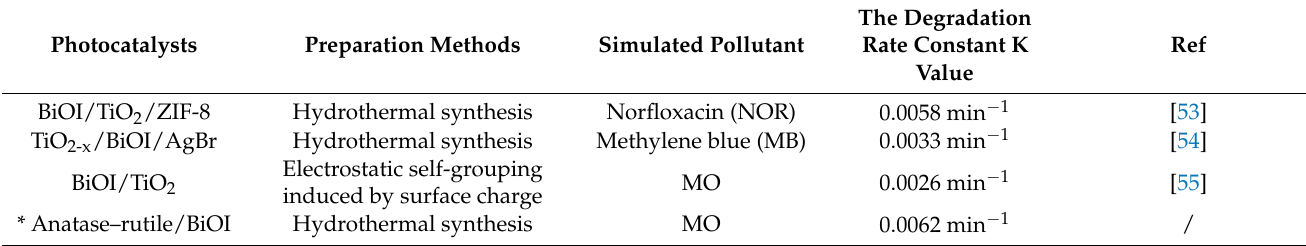
Table 2. The recent literature review on TiO 2 /BiOI and their photocatalytic efficiency under visible light illumination.